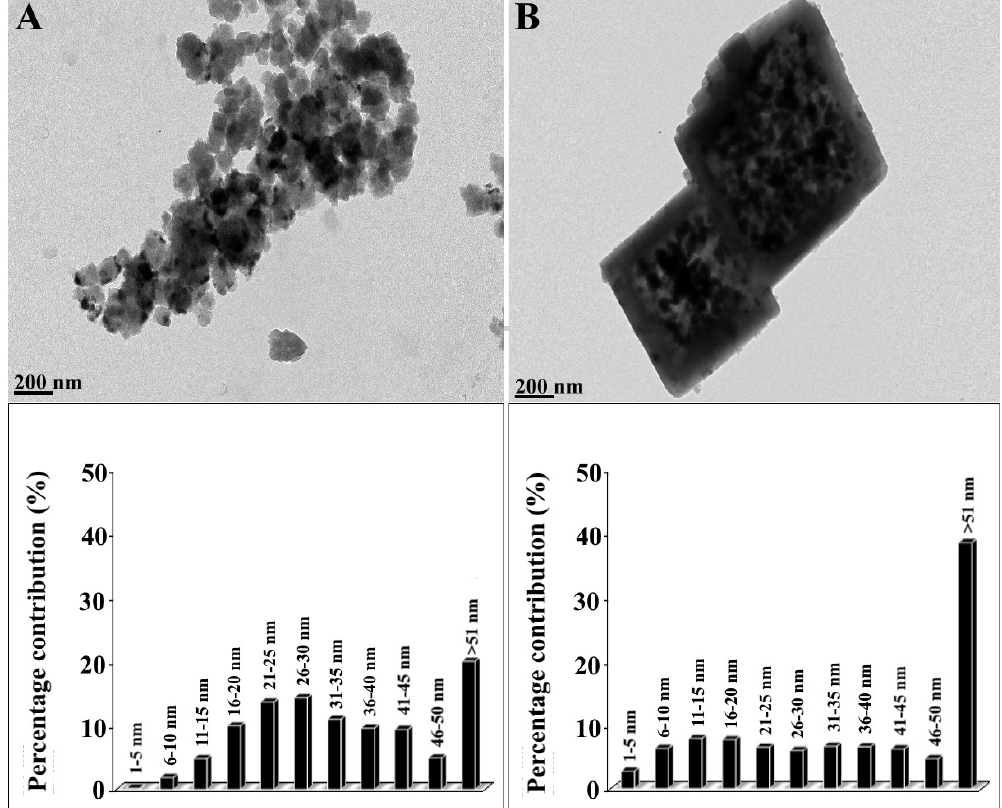
Figure 8. TEM images and metal nanoparticle size distribution on ( A ) Red-Mi-Co 20 AlBeta and ( B ) Red-Me-Co 20 AlBeta.